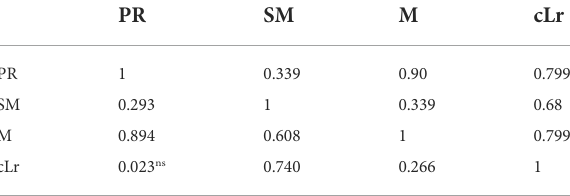
TABLE 3 Pearson correlation coef fi cient (r) calculated between 10 pairs of lodging-related traits in structured rice population of 795